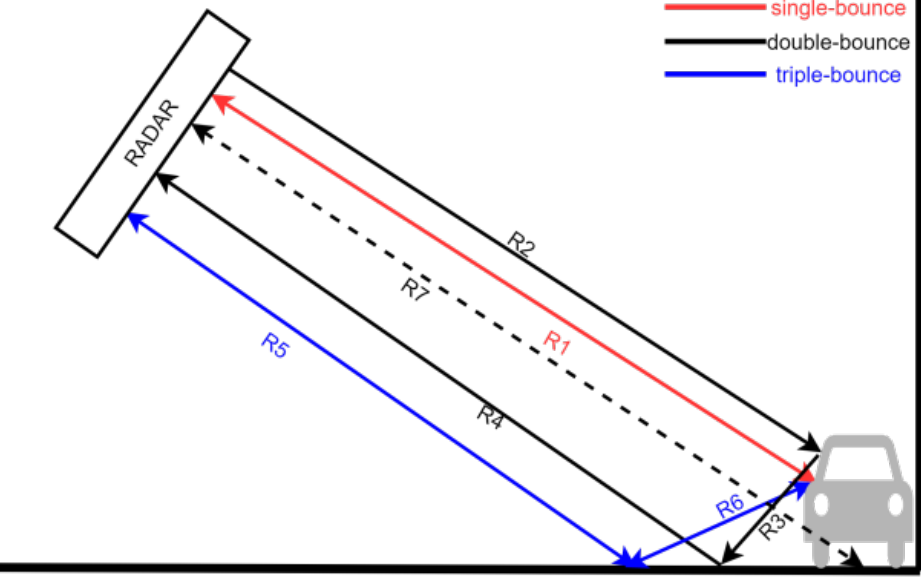
Figure 3. Schematic diagram of main scattering paths. Single-bounce scattering: The transmitting and receiving path is R1 → R1 which is shown by the red path in Figure 3. The single-bounce scattering slant range R single of